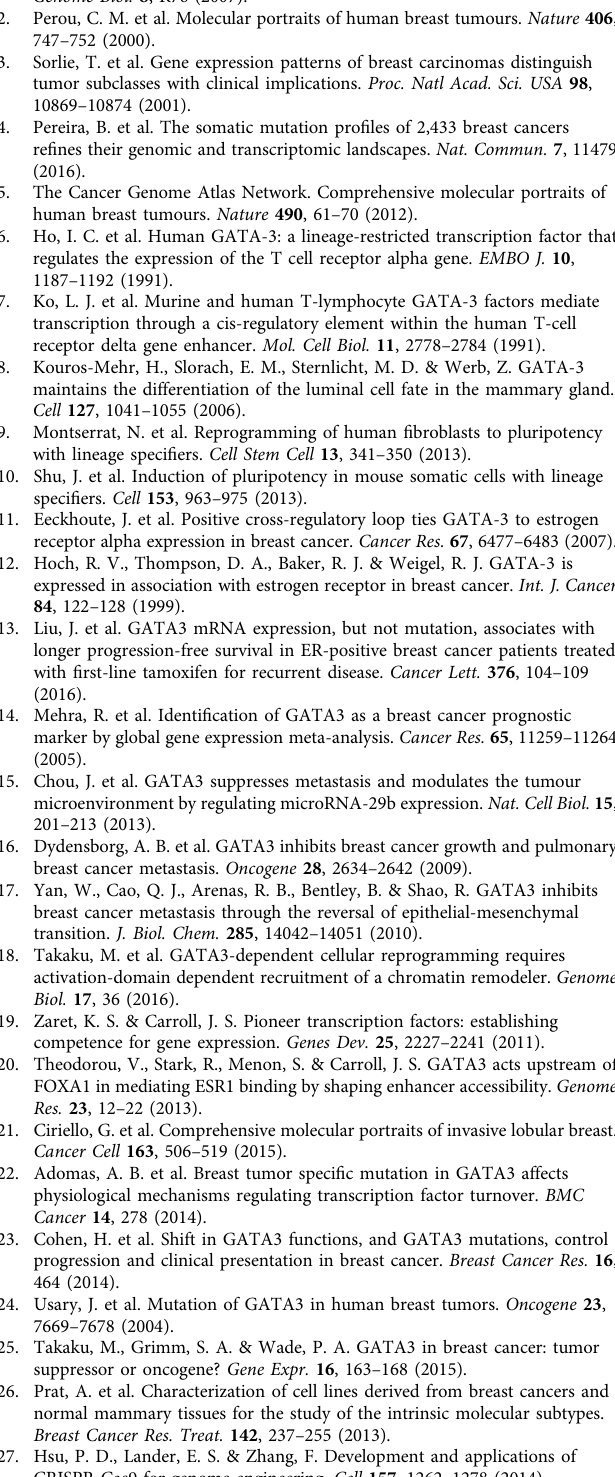
Supplementary Figure 1g. Fisher ’ s exact tests were applied to Supplementary Fig- ures 1e and 7h. Mann – Whitney tests were applied to Figs. 1f, 5f and 7e and Supplementary Fig. 7g. χ 2 tests were applied to Supplementary Fig.